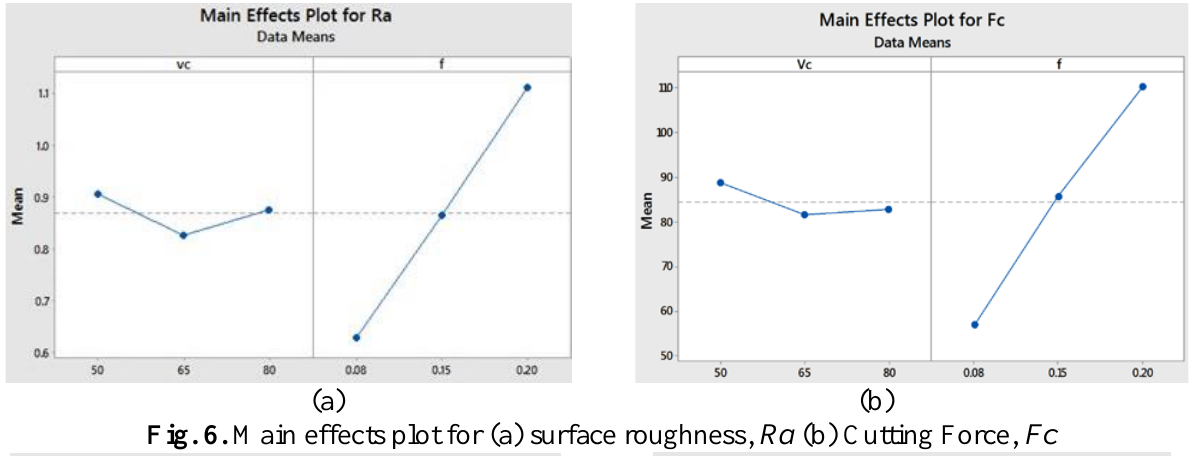
Fig. 6. Main effects plot for (a) surface roughness, Ra (b) Cutting Force,